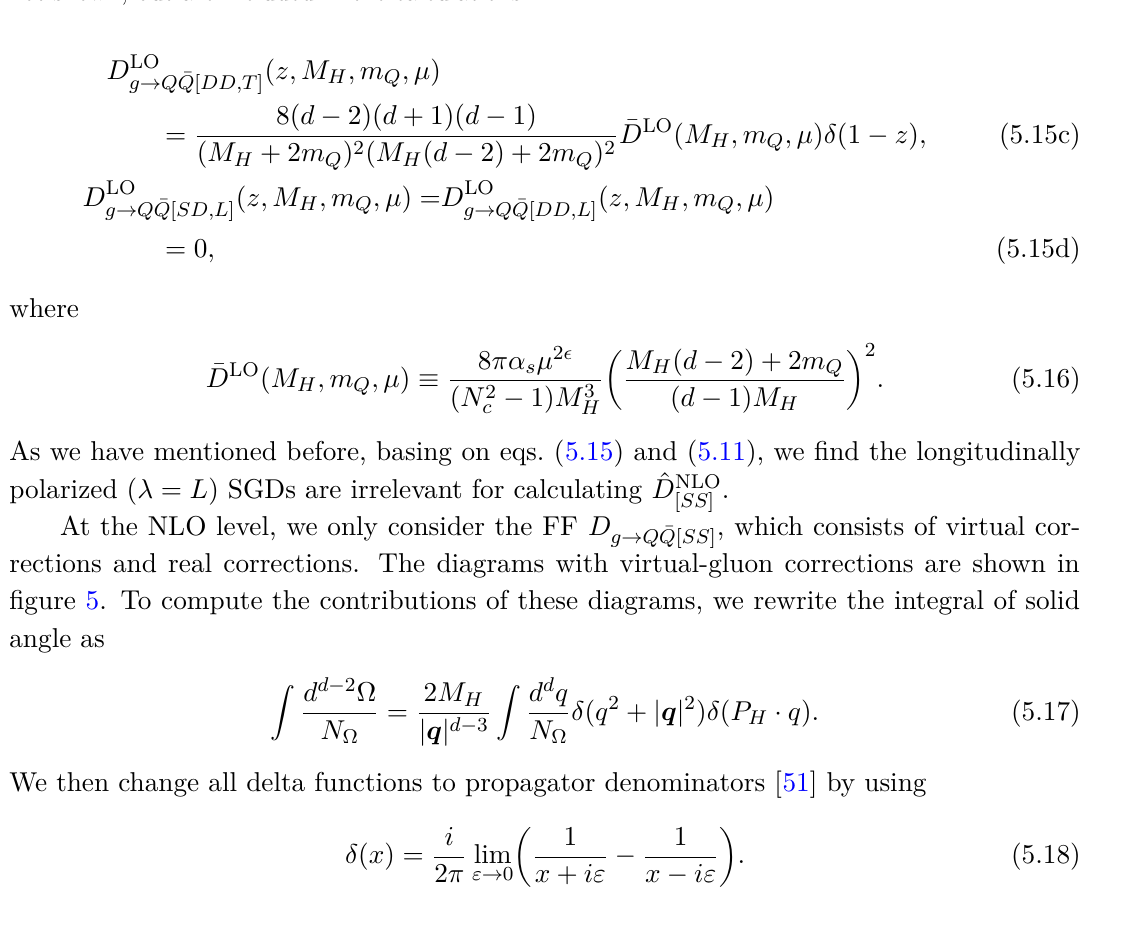
Figure 5 . Feynman diagrams for virtual correction of the FF at NLO in Feynman gauge. The double solid line represents the gauge link along l direction. The complex conjugate diagrams are not shown, but are included in the